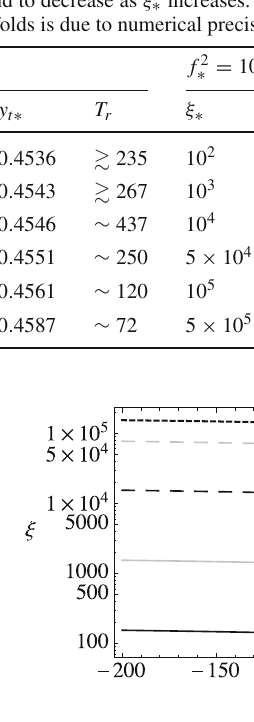
Fig. 5 Running of coupling ξ for various values of initial conditions ξ ∗ = 10 2 (black solid line), 10 3 (grey solid line), 10 4 (big dashed black line), 5 × 10 4 (big dashed grey line) and 10 5 (small dashed black line). For these flows we took f 2 ∗ = 10 − 8 , λ ∗ = 0 . 1, ρ ∗ = 1 . 5 and (cid:2) = 10 −